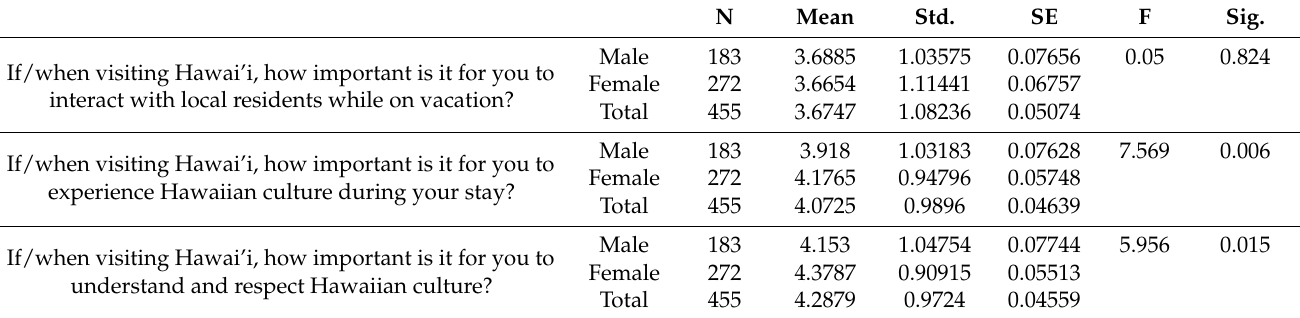
Table 3. Participants’ perceptions of the importance of encounters with Hawaiian culture, by